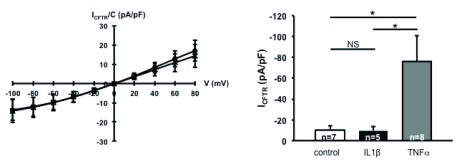
Effect of IL-1β on F508del-CFTR expressing HeLa cells.* indicates significant results. I
CFTR recorded in F508del-CFTR-expressing HeLa cells by patch clamp. Mean CFTR related current-voltage relationships recorded in the presence of 400 µM CPT-cAMP/100 µM IBMX (
O) and the presence of 10ng/ml IL1β + CPT-cAMP/IBMX (
X). The current was normalized to capacity (pA/pF), left panel. The normalized CFTR currents are depicted as mean + SEM, in absence (control, white column) or presence of 10ng/ml IL1β for 10min (IL1β, black column) or presence of 50ng/ml TNFα for 10min (TNFα, grey column). IL1β did not significantly increase I
CFTR compared to control (NS), but TNFα significantly increased I
CFTR compared to IL1β (p=0.03) and control (p=0.03; unpaired Student’s t-test), right panel.